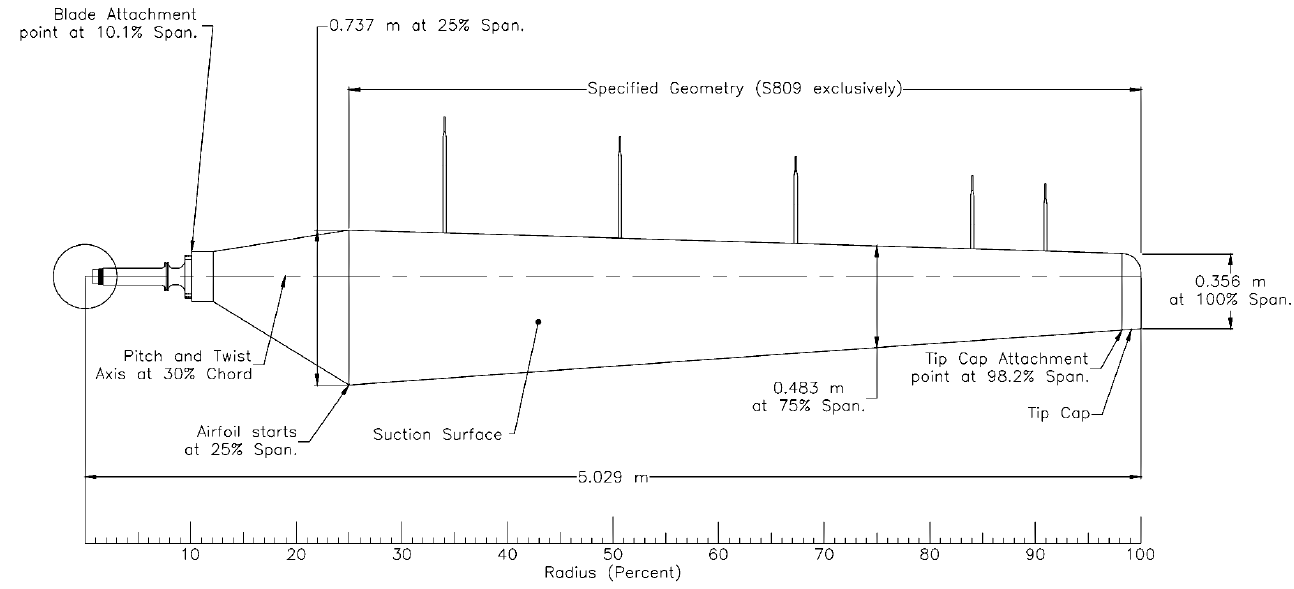
Figure 2. Blade planform dimensions (reproduced from [8] ).